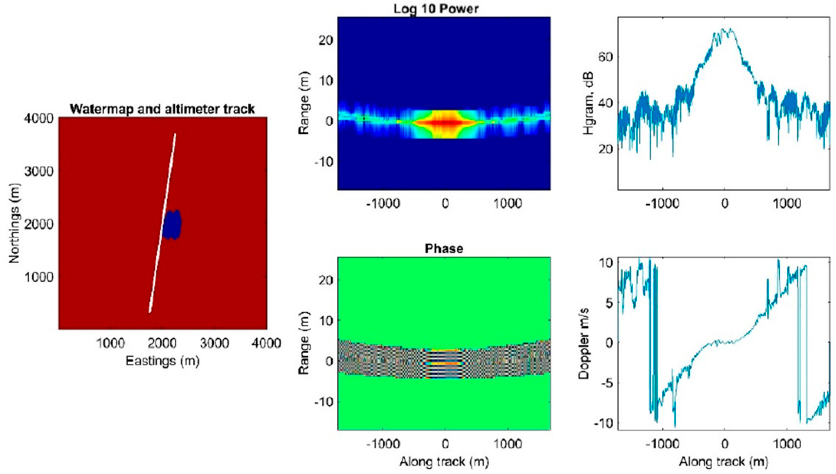
Figure 5. Model for the peanut-shaped lake example. Power at CPA is about 70 dB.